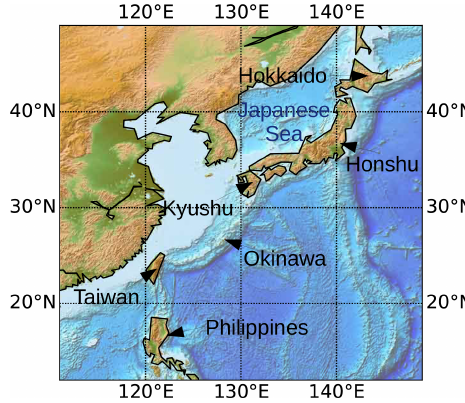
Figure 1. Physical map of the study region, including references to the most relevant geographical aspects mentioned in the